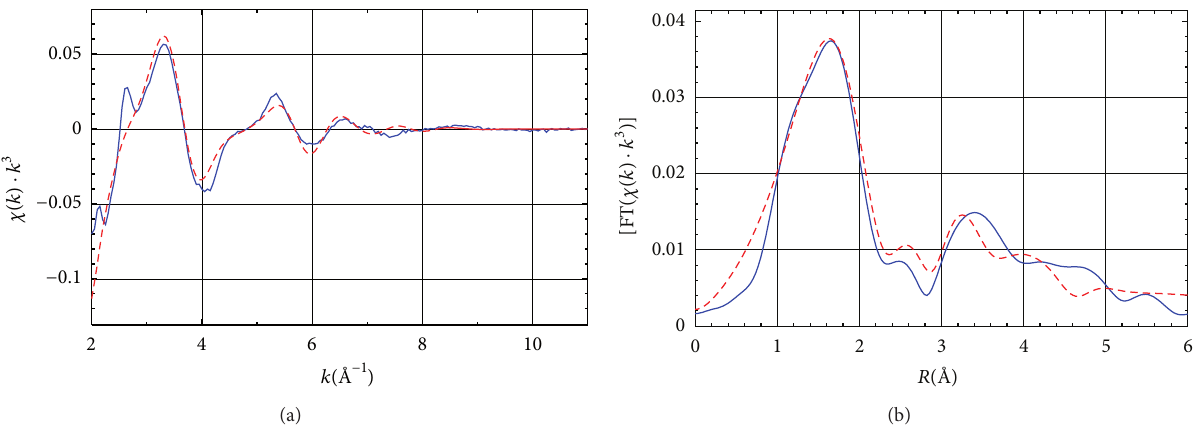
Figure 2: Ca K-edge EXAFS data of CaHAp experiment (solid lines) and fit to data (dashed lines). (a) The 𝑘 3 -weighted 𝜒(𝑘) and (b) Fourier transformations of the 𝑘 3 -weighted EXAFS spectra. Radial distribution functions were not corrected for phase shift (shorter distances by 0.3-0.4 ˚A with respect to crystallographic values). Note: the dotted lines are best